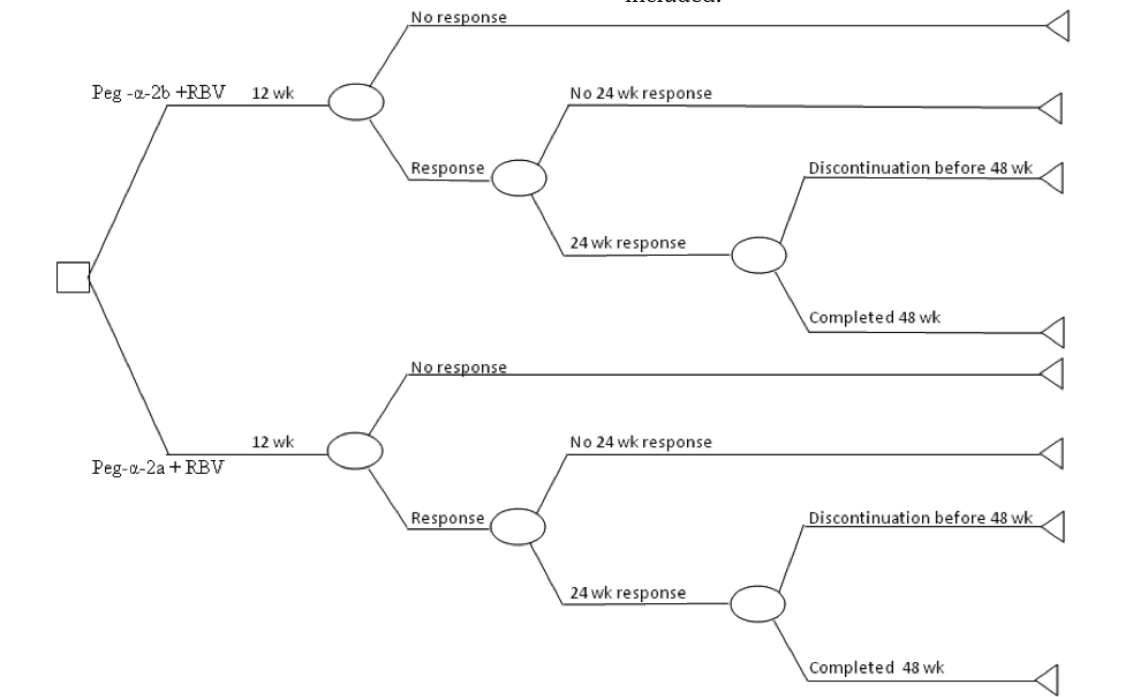
Figure 1: Decision tree comparing two strategies for genotype 1 HCV